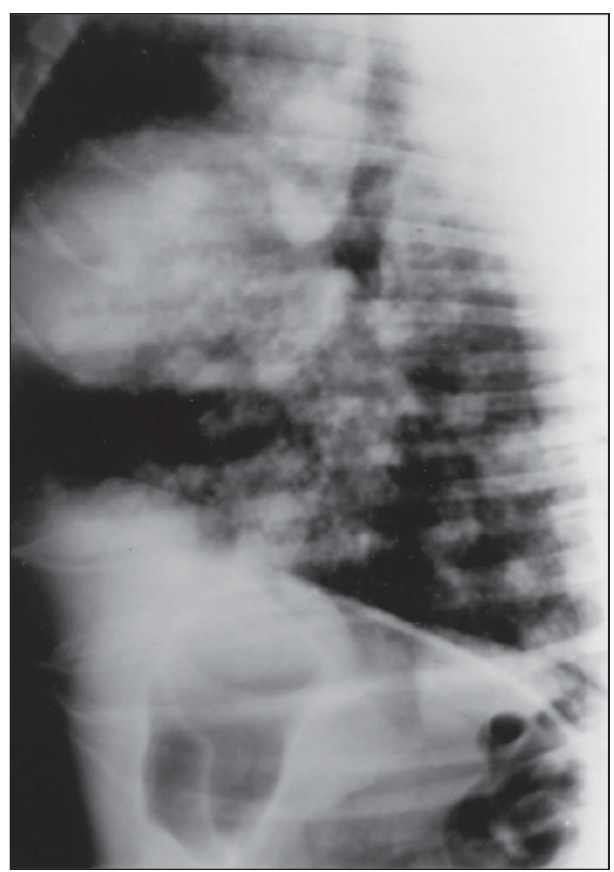
Figure 3) Canine blastomycosis. Chest x-ray of index case 2 showing diffuse pulmonary